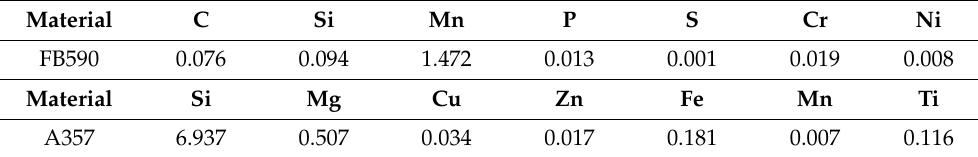
Table 1. The chemical composition of base materials